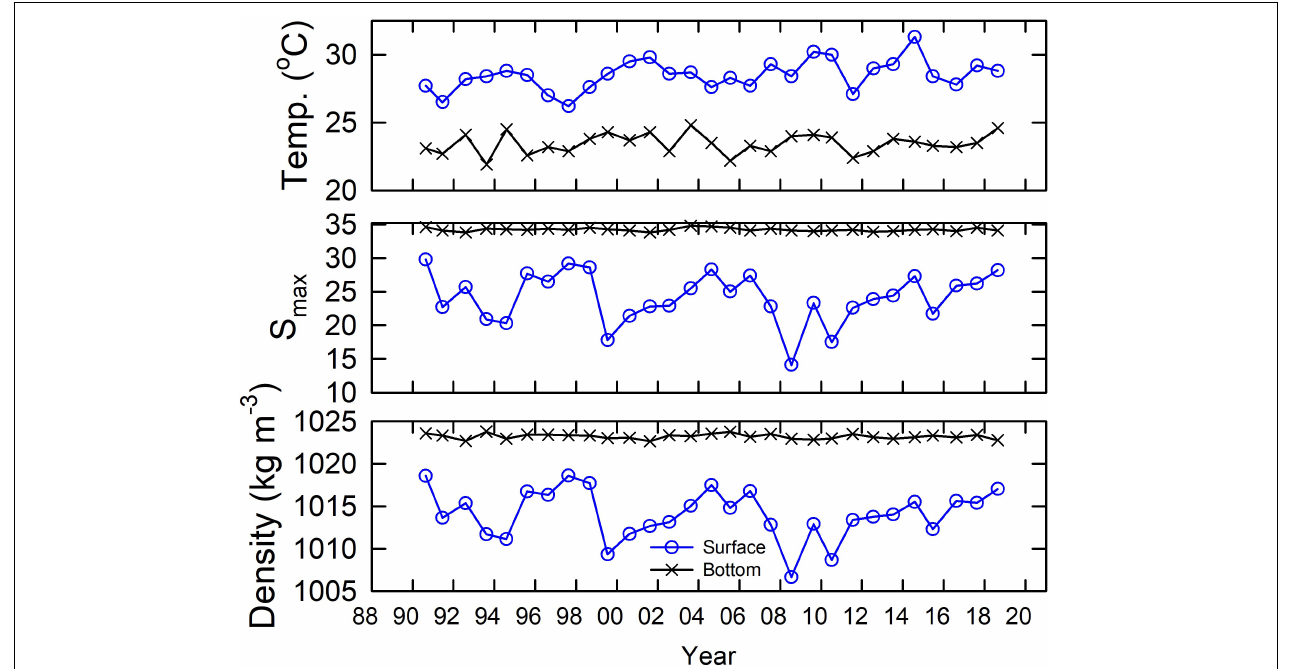
FIGURE 6 | The corresponding temperature, salinity, and density of surface and bottom seawaters when the bottom water S reaches its highest value each year (S max